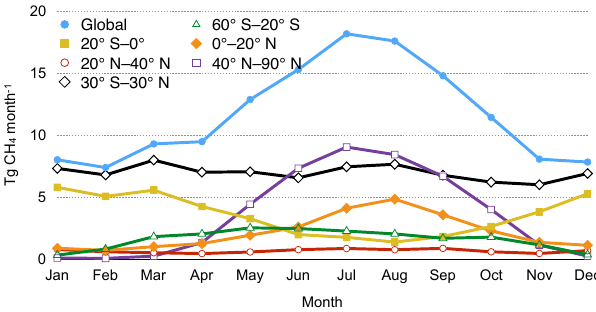
Figure 1. Monthly wetland methane emissions (TgCH 4 month − 1 ) for several latitudinal bands for the optimized